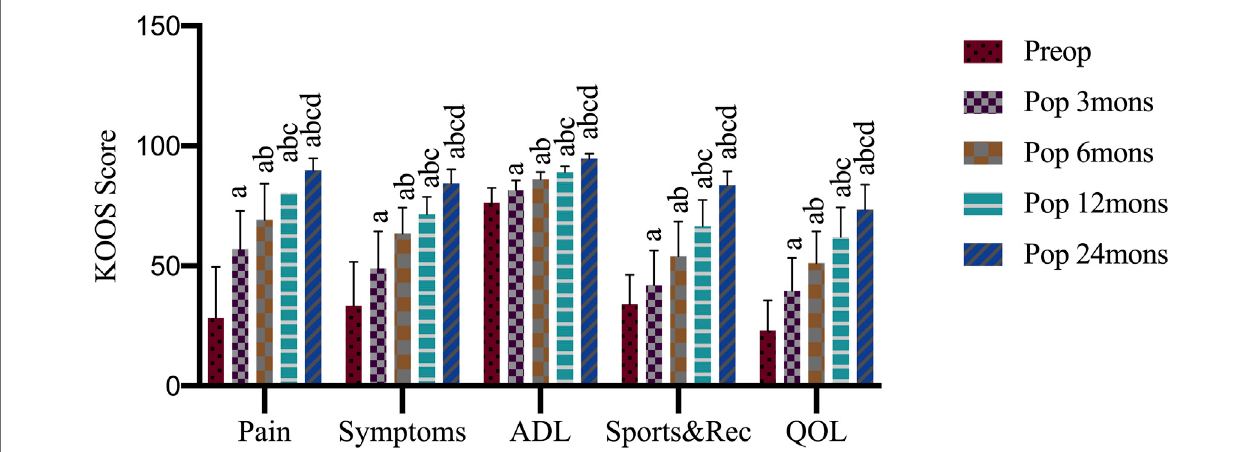
FIGURE 2 | Knee injury and osteoarthritis outcome score (KOOS) outcome after operation. Preop, preoperation; Pop, postoperation; mons, months; ADL, activitiesofdailyliving;SportsandRec,sportsandrecreation;QOL,qualityoflife;a, p < 0.05(vs.preoperatively;b, p < 0.05(vs.threemons);c, p < 0.05(vs.sixmons);d, p < 0.05 (vs. 12